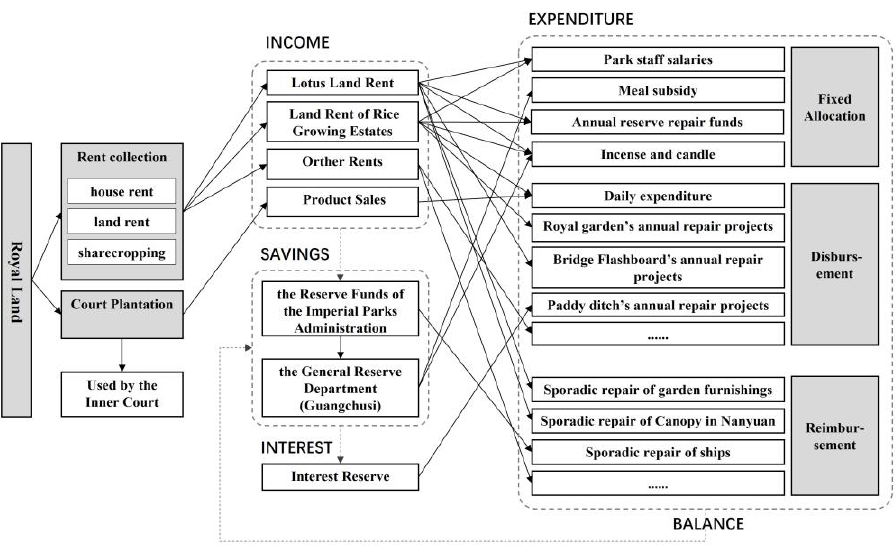
Figure 20. The flow of funds for royal land management (taking the Imperial Parks Administration as an example).